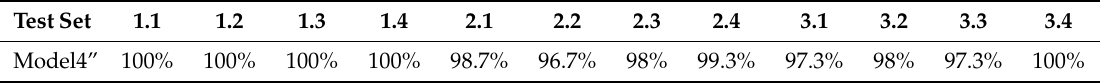
Table 8. Classification accuracy of Model4” on three, four, and five colours. Test